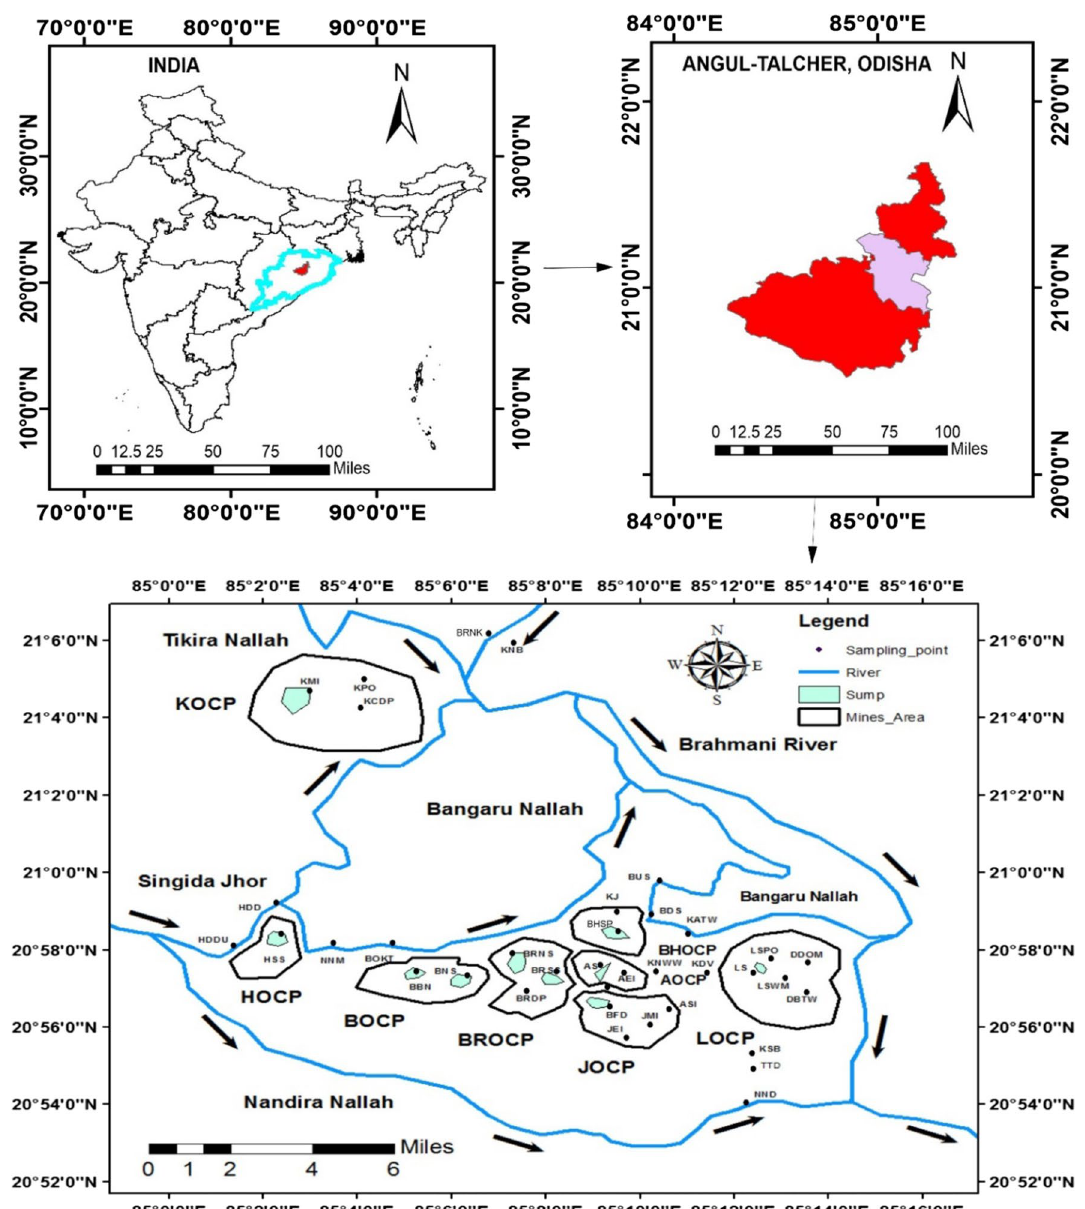
Fig. 1 Study area map of Talcher